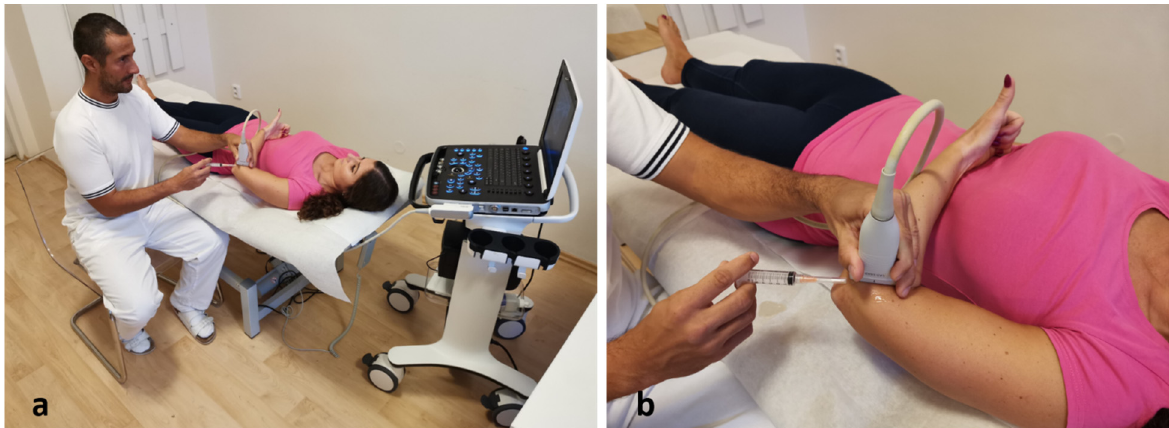
Figure 3. Ultrasound-guided injection for tennis elbow: ( a ) position of the patient (supine, elbow flexed to 90°, internal rotation of the shoulder, thumb extension); ( b ) position of the probe on the lateral epicondyle perpendicular to the long axis of the forearm.